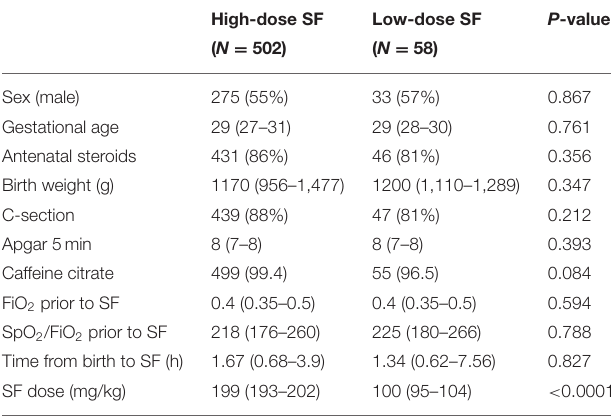
TABLE 4 | Clinical characteristics of the high- and low-dose